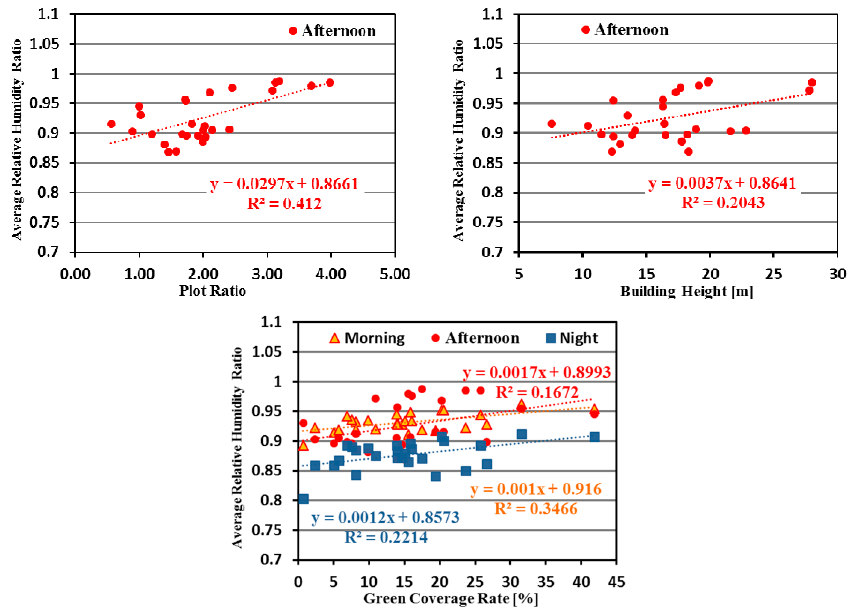
Figure 9. Relationships between urban morphology index ( x -axis) and relative humidity ratio from the mobile and reference point ( y -axis) measurements in the commercial district. Table 7. Pearson’s correlation coefficients between air temperatures (relative humidity) at different times of day for the residential district ( n = 23).